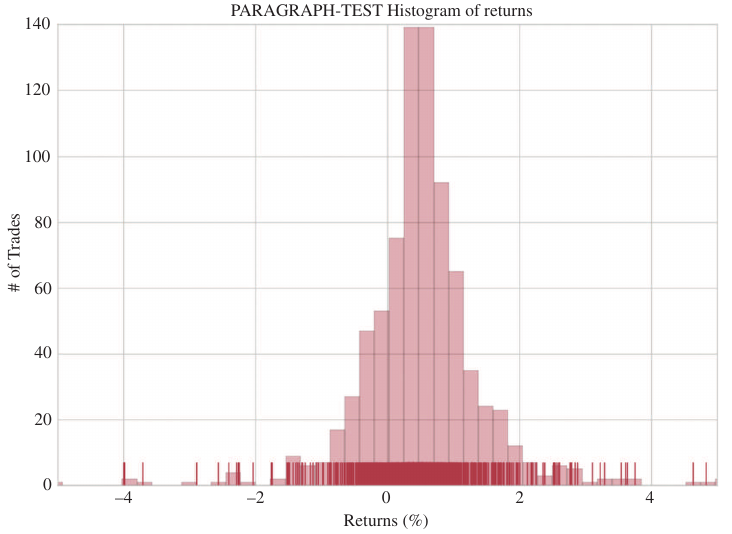
Figure 8: PARAGRAPH Histogram of Percentage Returns Focused on Range ( − 5%, 5%).